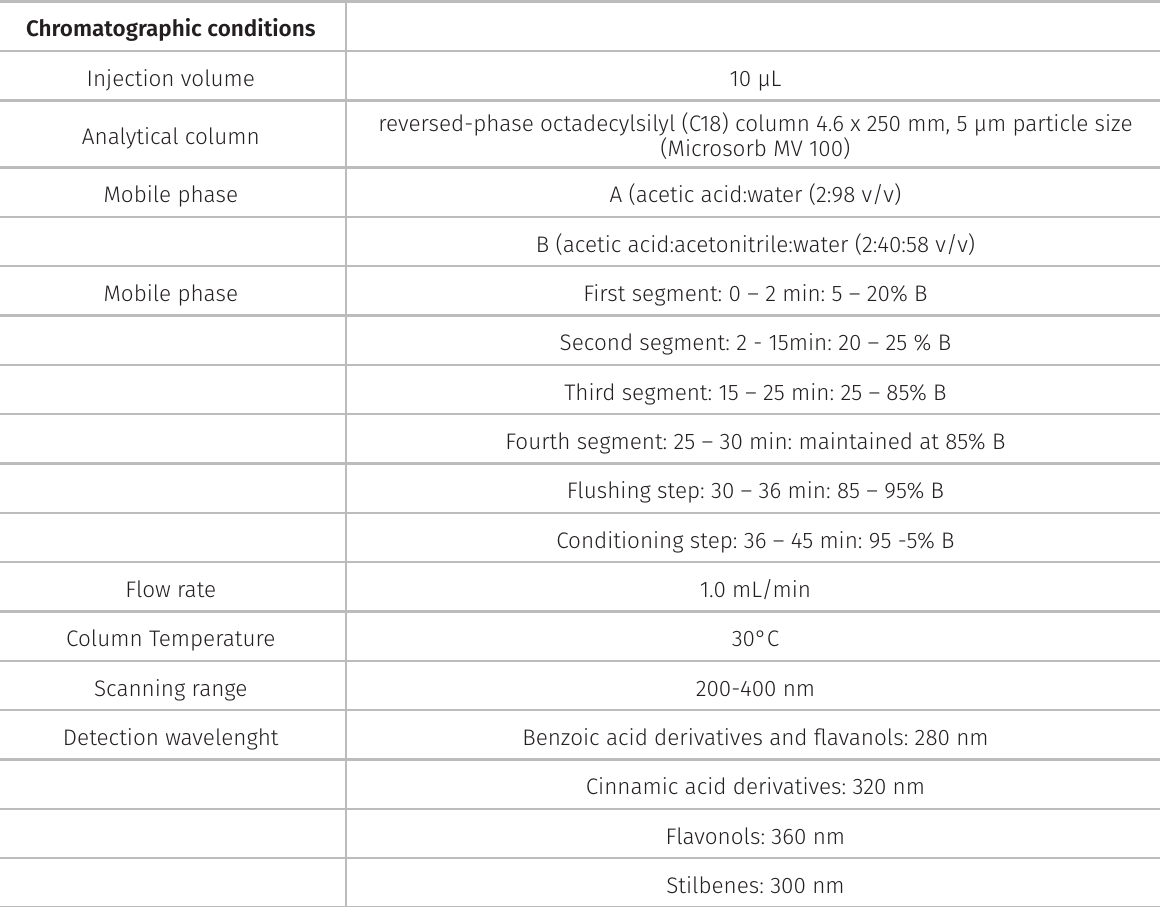
Table I. Chromatographic conditions for the determination of phenolic compounds in grape and apple pomace